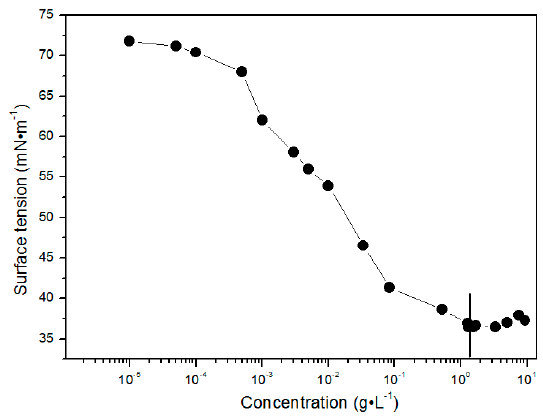
Figure 2. Surface tension changes of mPEG-maleic rosin as a function of concentration.